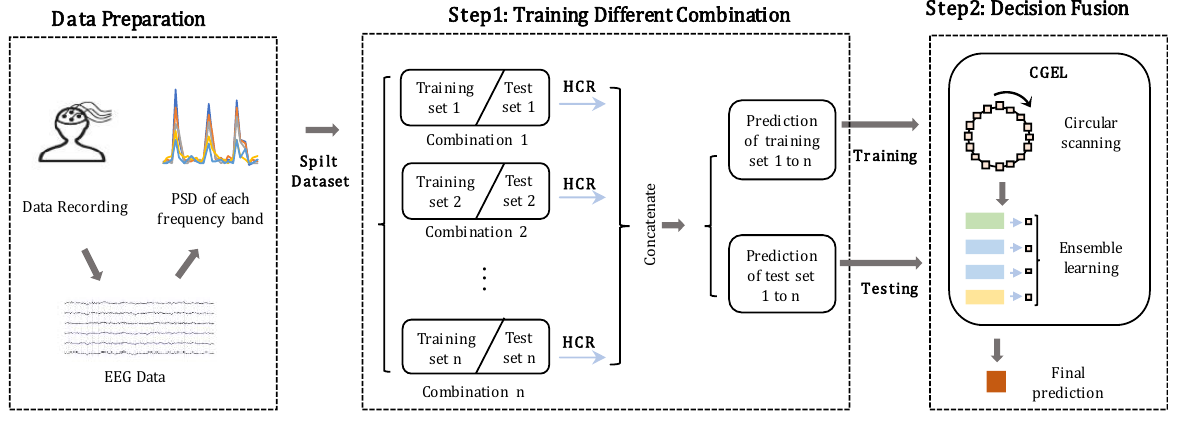
Figure 1. The flow chart of HCRC-CGEL framework.